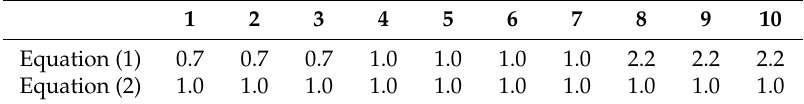
Table 2. Weibull’s β parameters obtained for both physical assets (year 1 to year 10).